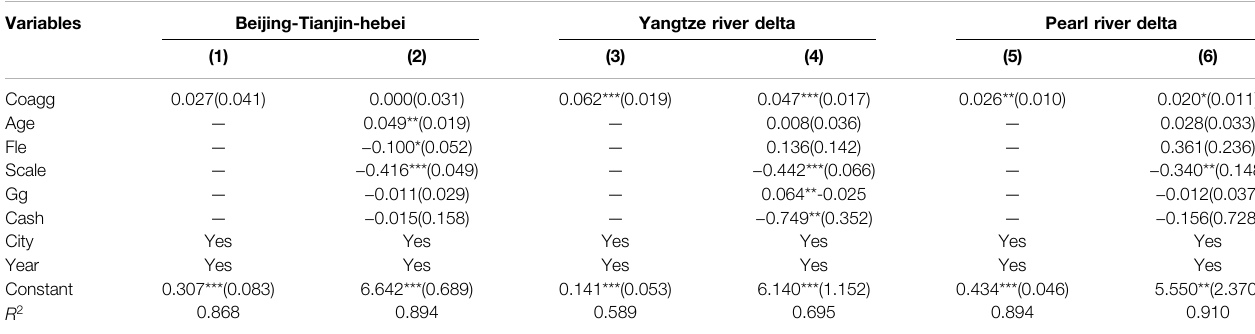
TABLE 4 | Regression results of distinguishing regions.